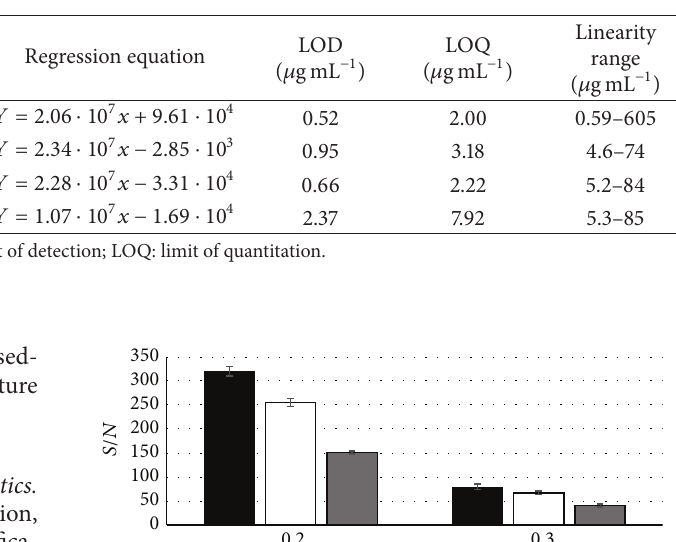
Table 1: Validation characteristics of the CUPRAC postcolumn assay.